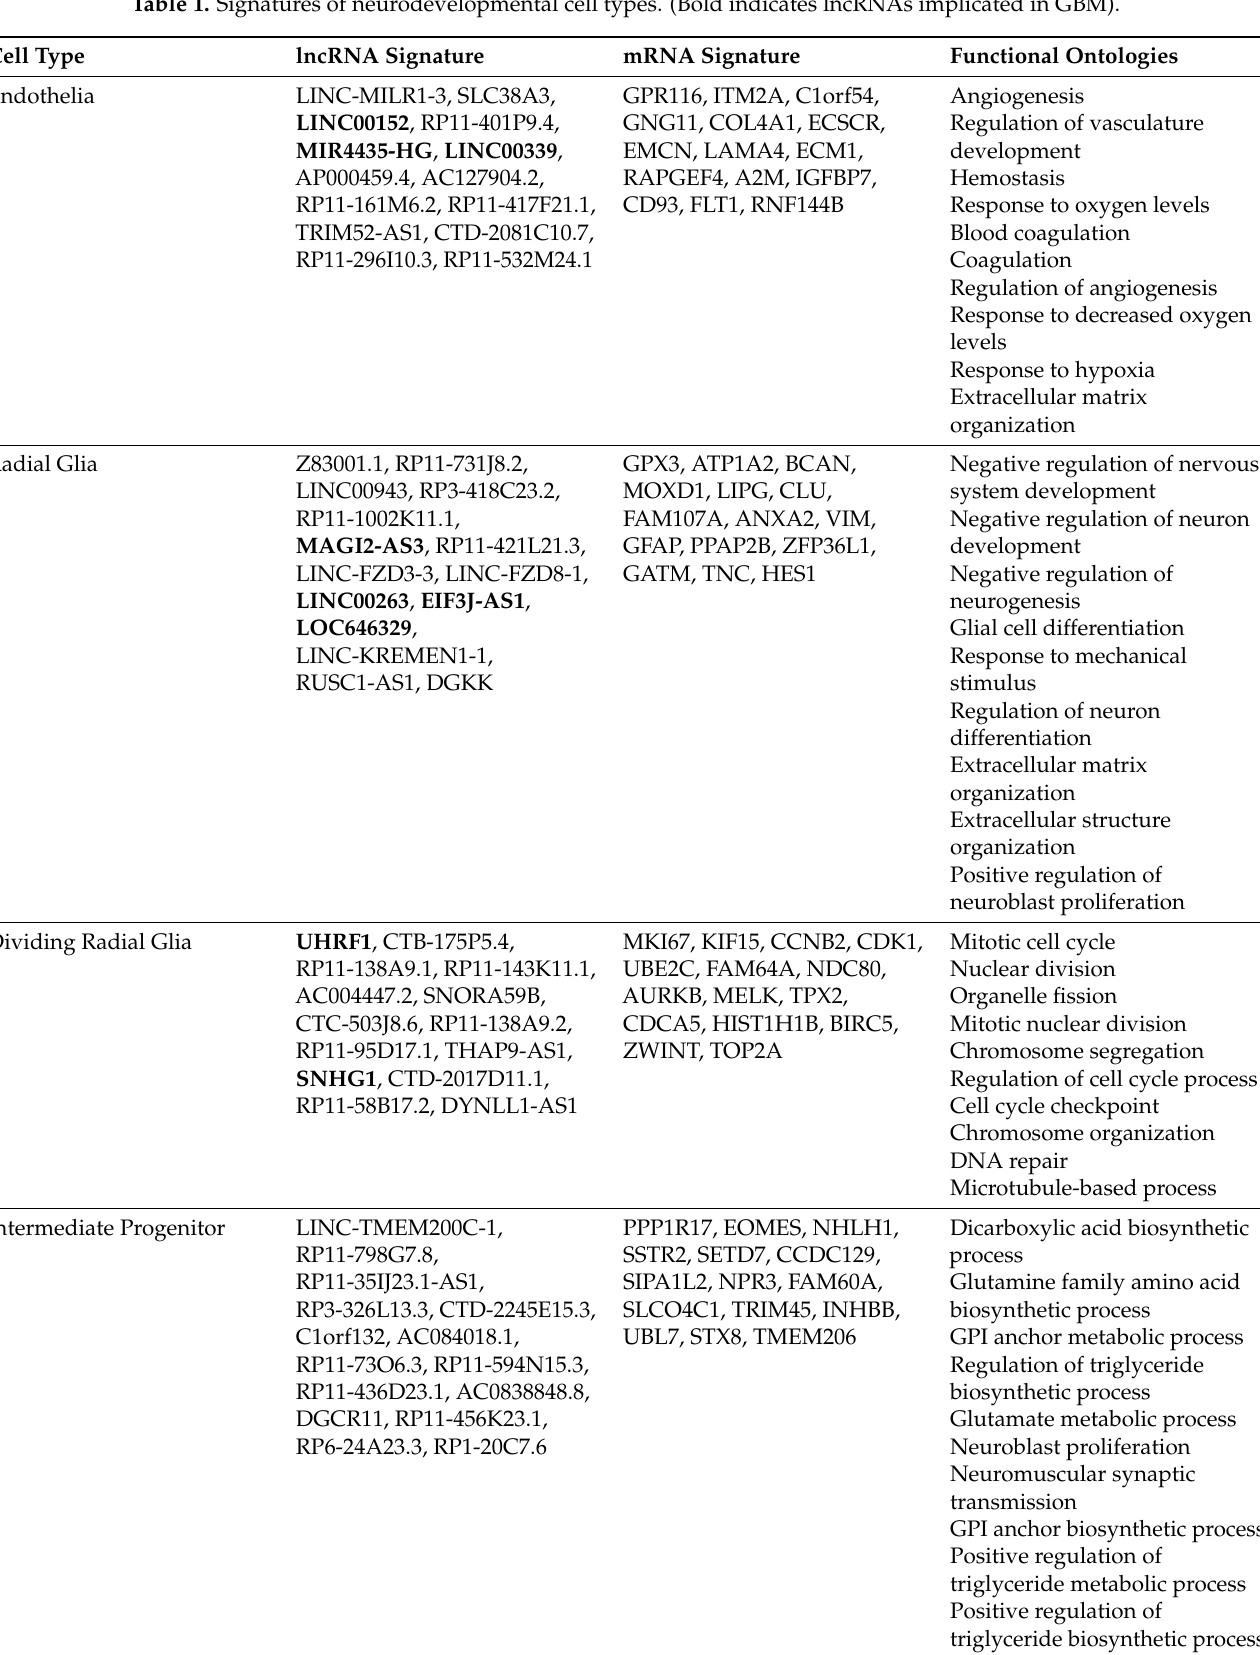
Table 1. Signatures of neurodevelopmental cell types. (Bold indicates lncRNAs implicated in